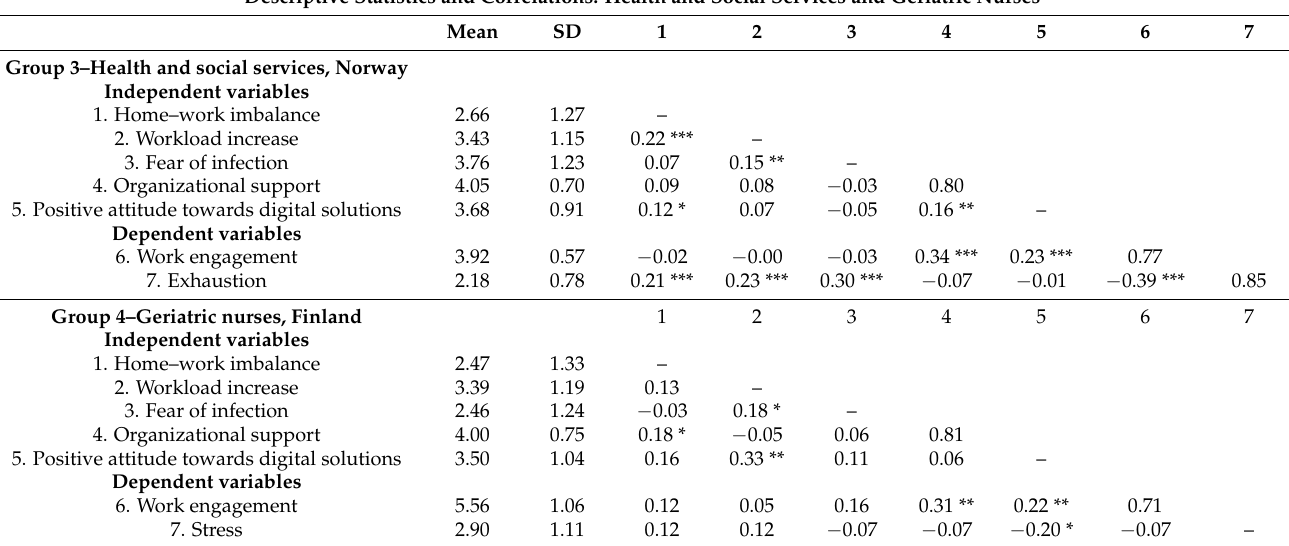
Table 2. Means, standard deviations (SD), and correlations for occupational Groups 3 and 4—Data from health and social services in Norway ( n = 267) and geriatric nurses ( n = 105) in Finland. Descriptive Statistics and Correlations: Health and Social Services and Geriatric Nurses Mean SD 1 2